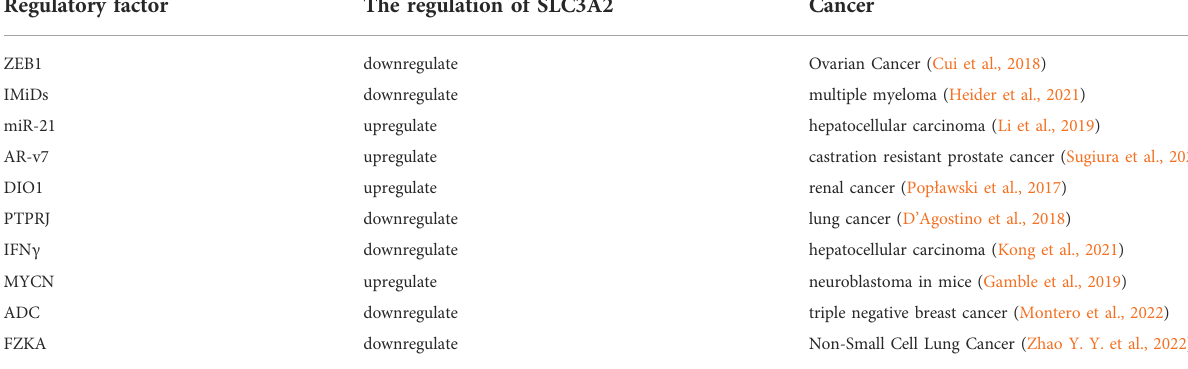
TABLE 2 Regulatory factors of